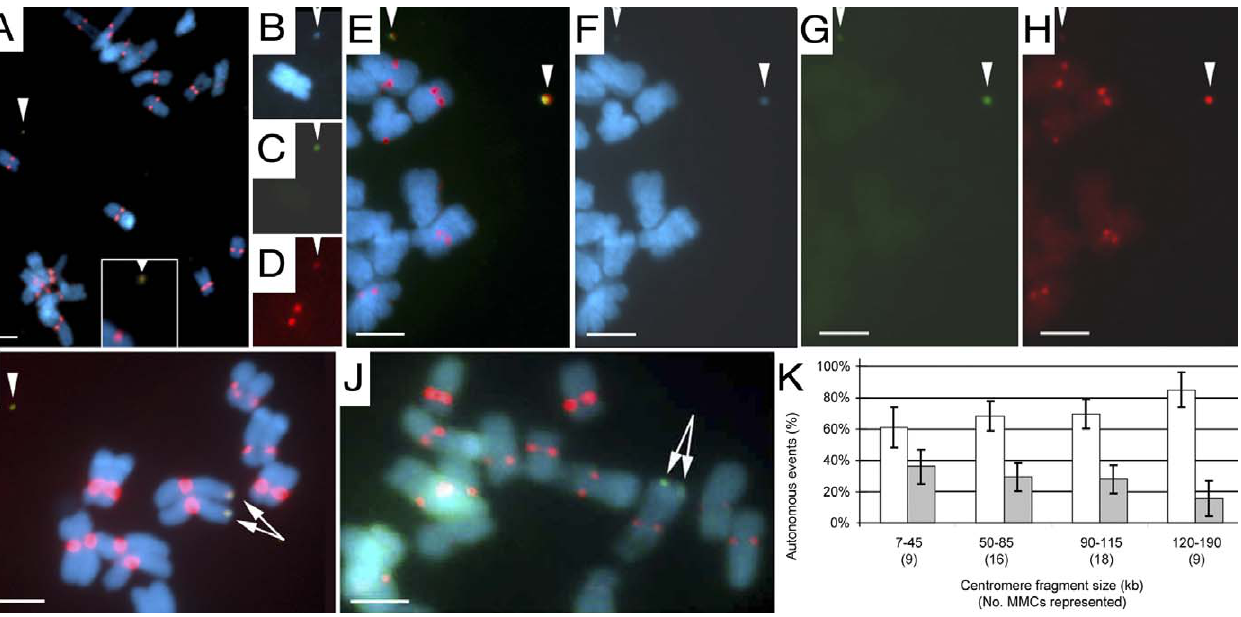
Figure 1. Generation of Autonomous Minichromosomes (A–H) Metaphase chromosome spreads from MMC1 event V-1: (A–D) T1 plant; (B–D) correspond to the region denoted by the arrowhead in (A); (E–H) T2 plant. DNA is stained with DAPI ([B F], blue) and labeled with FISH probes specific for the DsRed and nptII gene cassette ([C, G], green); or centromere sequences ([D, H], red). (I, J) Event V-4 with autonomous and integrated copies of MMC1 (I); pCHR758 (noncentromeric control) (J). Autonomous minichromosomes (arrowheads); integrated constructs appear as pairs of FISH signals (arrows); size bar, 5 l m. (K) Centromere fragments across a wide size range enable autonomous MMC inheritance. For each size category, the percentage of transformation events (total ¼ 52) that yielded only an autonomous MMC (white bars) or both an autonomous and integrated MMC in the same cell (grey bars) is shown; the number of MMCs in each category is noted parenthetically; error bars indicate standard error.